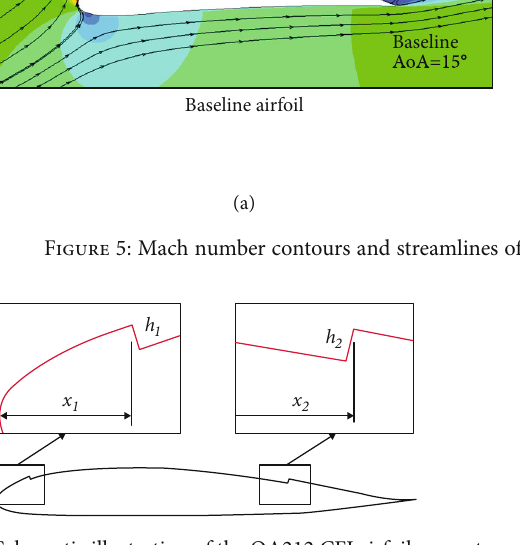
Figure 6: Schematic illustration of the OA212 CFJ airfoil